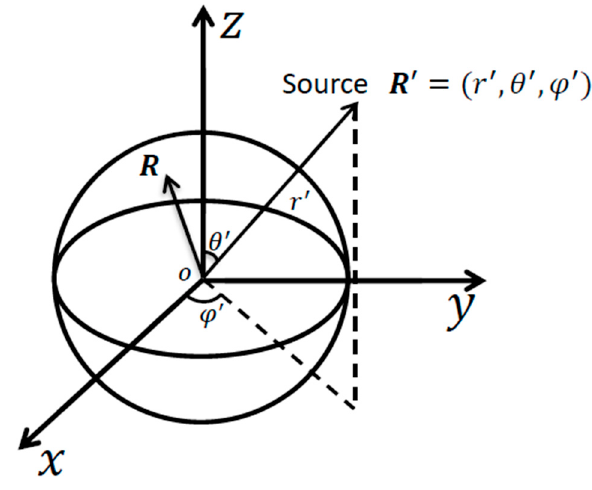
Figure 3. Air-Seawater two-layer model in sphere coordinate system.